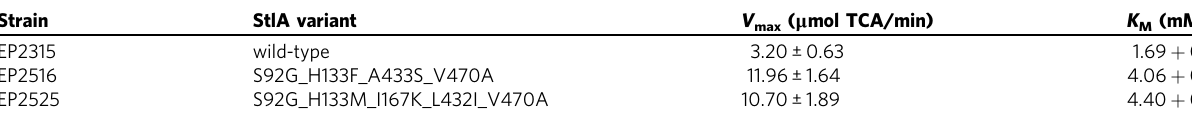
V max and K M average of n = 3 biological replicates ±s.d.